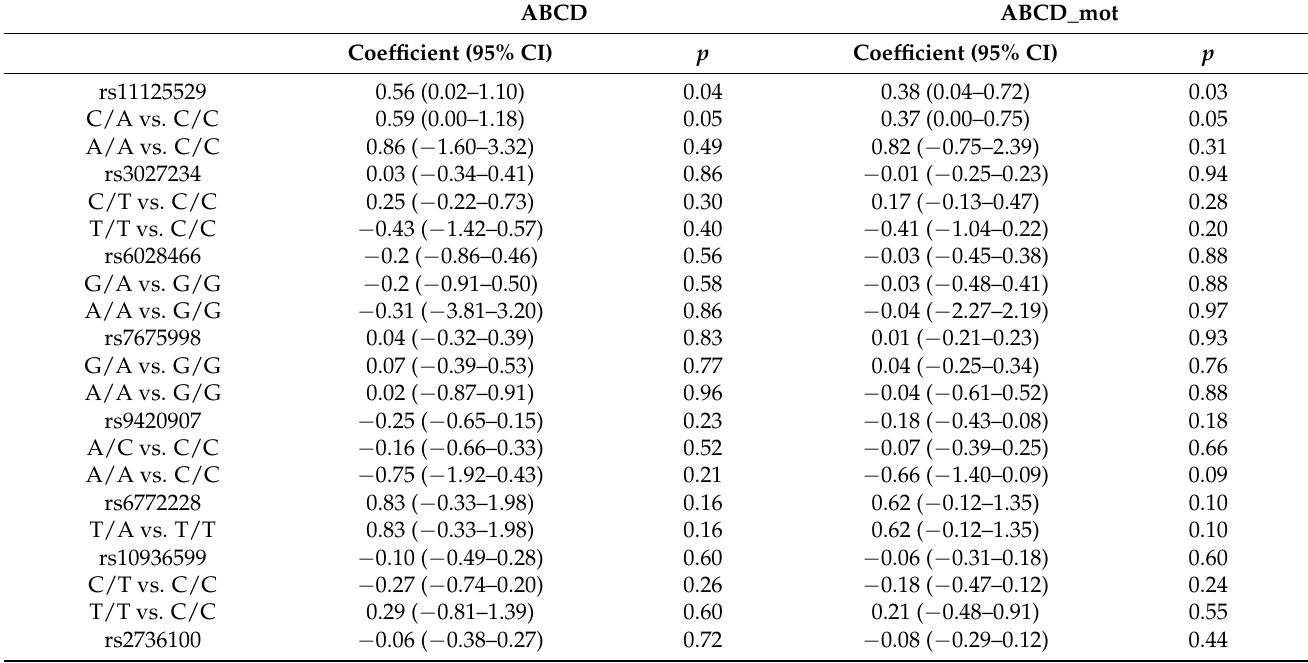
Table 6. ABCD scores association analyses results.